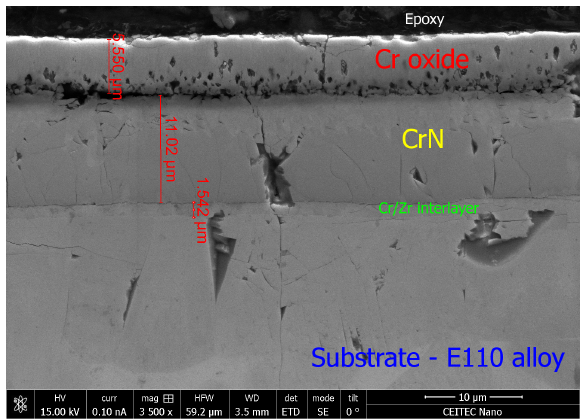
Figure 2. SEM micrograph of E110 cladding coated using PVD with CrN after high temperature steam oxidation at 1200 ◦ C for 9 minutes. Even after oxida- tion the coating is homogeneous and its thickness can be easily controlled.